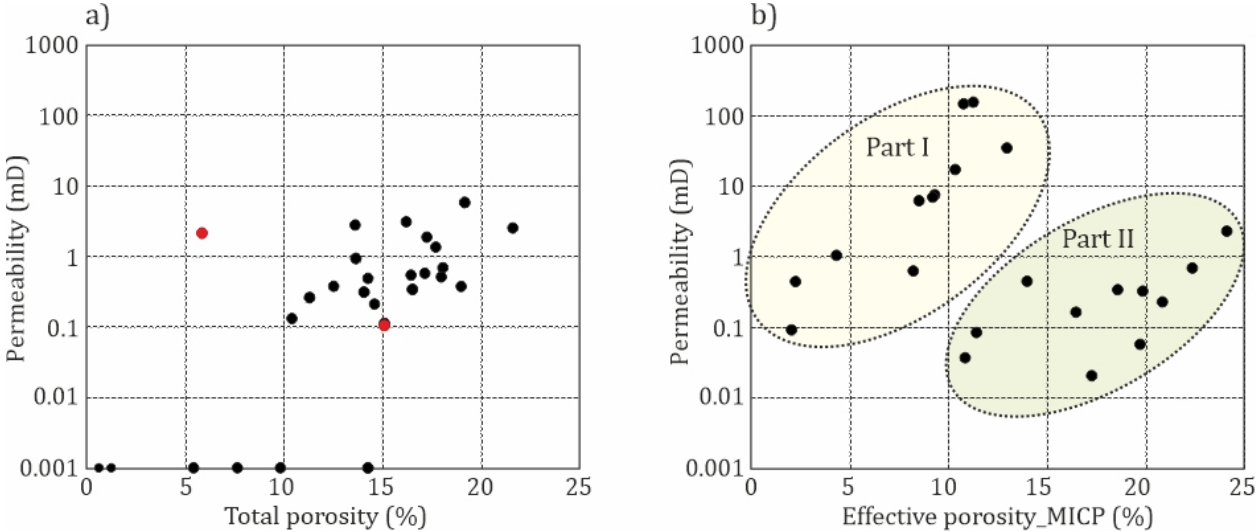
Figure 3. Relationship between permeability and total porosity or effective porosity_MICP, grainstone microfacies: ( a ) data from G-1 borehole; ( b ) data from G-6 borehole.